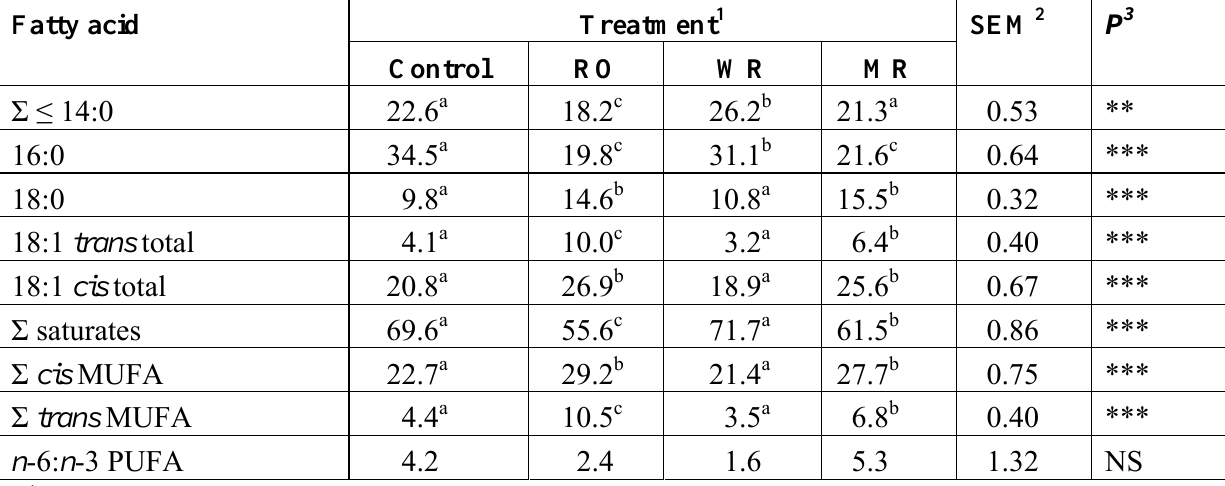
Table 2. Effect of form of rapeseed lipids in the diet on milk fatty acid composition (g/100g fatty acids). (from